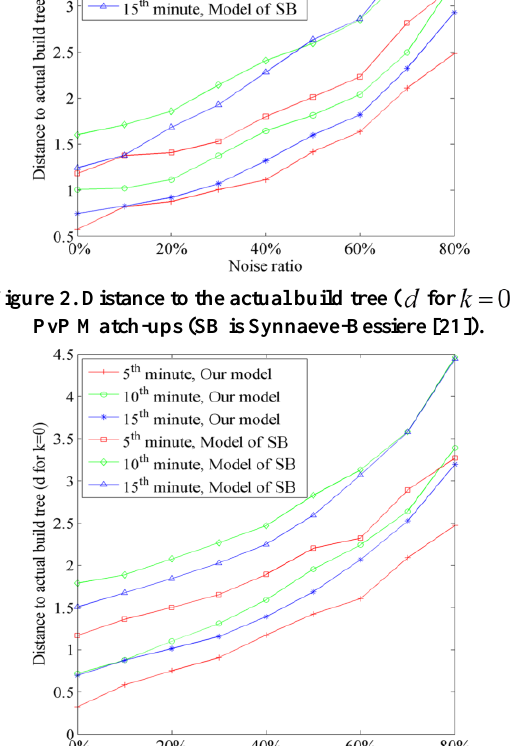
Figure 3. Distance to the actual build tree ( for ) , PvT Match-ups (SB is Synnaeve-Bessiere [21]).